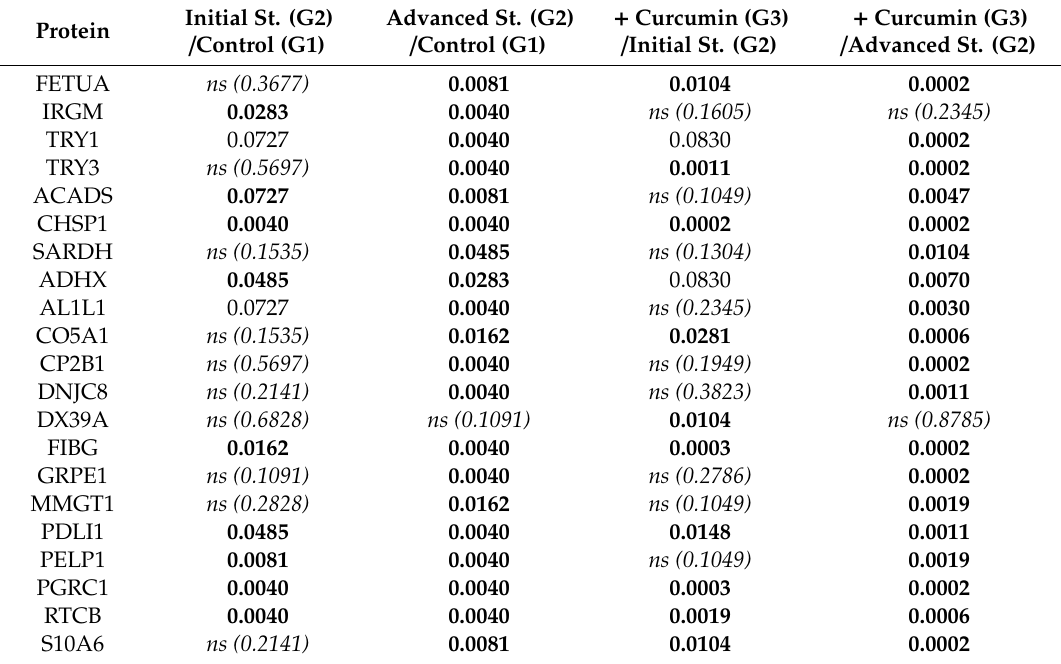
Table 1. Statistical analysis of di ff erential protein abundance between